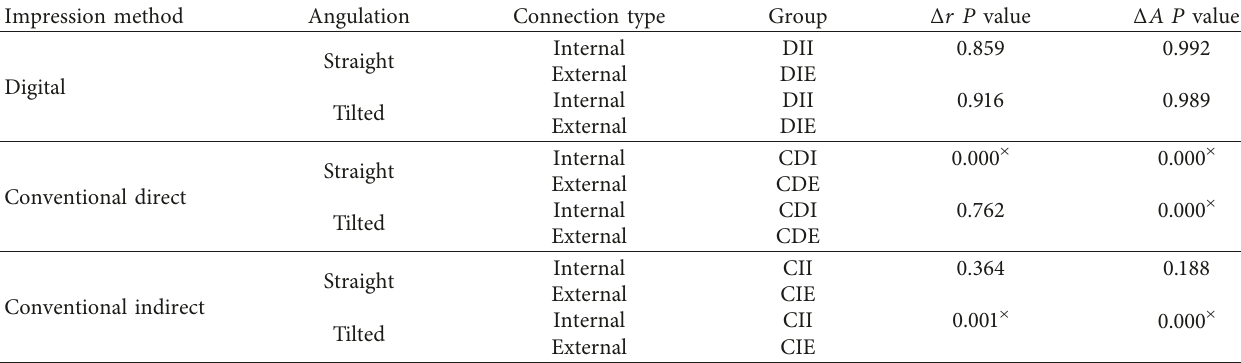
Table 4: The effect of the connection type by comparing inaccuracy values for each group at the implant angulation and impression